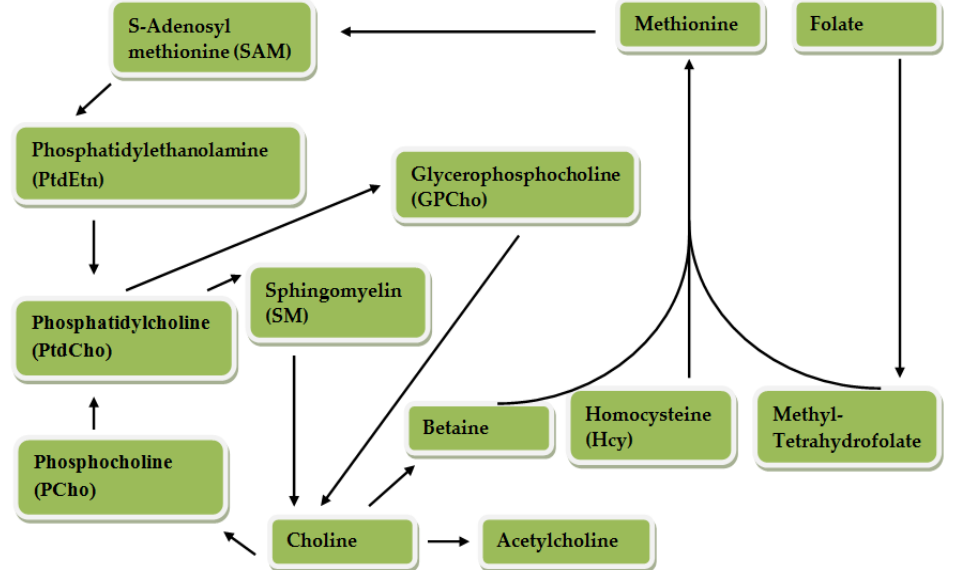
Figure 2. Choline metabolism. Betaine donates a methyl group to Hcy, for the formation of methio- nine which is converted to SAM, an important methyl donor. PtdCho is produced by SAM and PtEtn. PtdCho, PCho, SM and GPCho are components of the cell membrane produced from choline and can be hydrolyzed to form choline. PCho is also formed by PtdChO. Choline is synthesized through the action of phosphatidylethanolamine (PEMT) in the liver. Betaine and acetylcholine are synthesized from choline. Methyl-THF is a product of folate metabolism which can also be formed from the methyl group donated by betaine. Metabolism of folate and choline intersects because me- thyl tetrahydrofolate produced from folate metabolism can also donate a methyl group for the for- mation of methionine from Hcy [12].